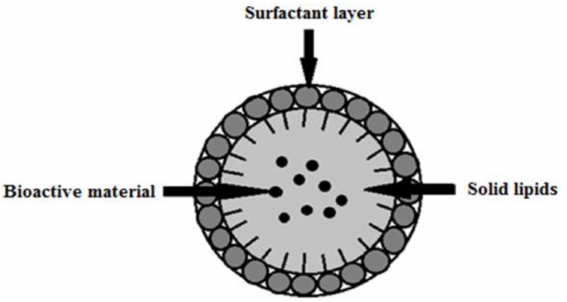
Figure 3. Structure of a solid lipid nanoparticle (SLN) stabilized by surfactant coating/layer